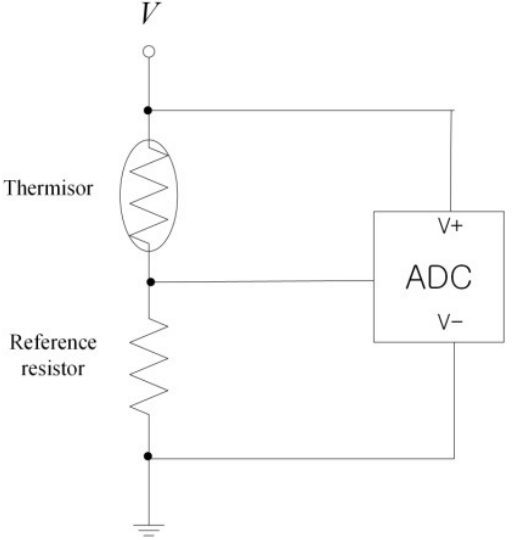
Figure 3. Thermistor resistance measuring circuit.